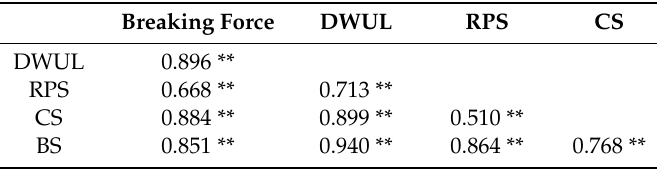
Table 3. Correlations between the stalk breaking force and the mechanical strength and dry weight per unit length (DWUL) of the basal internodes.